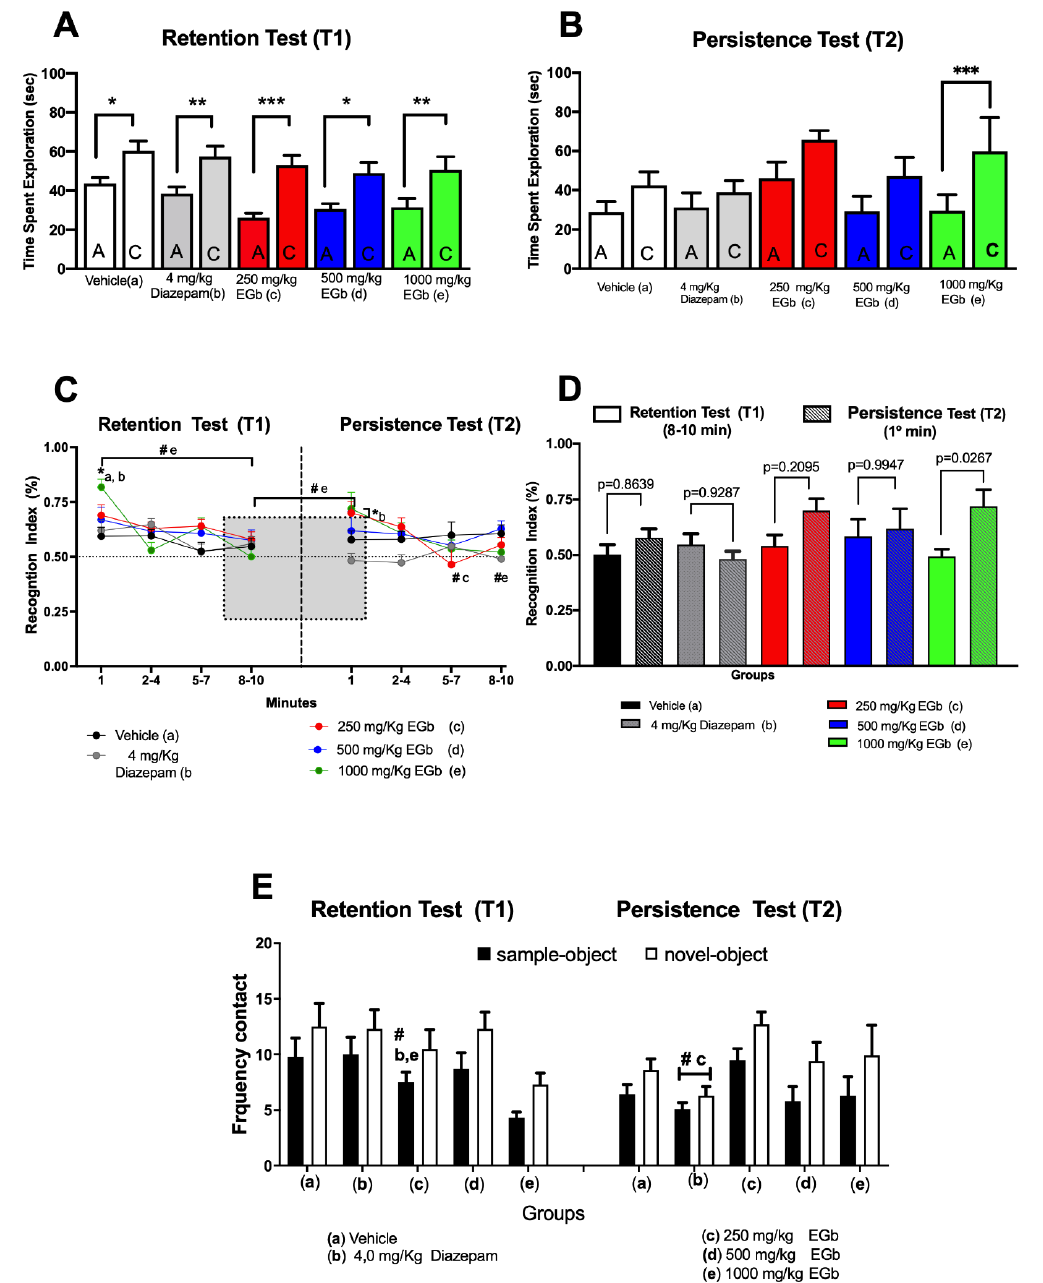
Figure 1. ( A ). Comparison of the mean of total time spent exploring/min the novel and sample objects in the retention test (day 8, n = 20/group), and the persistence test ( B ) (day 9, n = 10/group) between the control (diazepam- and vehicle-treated) and EGb-treated (250, 500 and 1000 mg/kg) groups. ( C ). The recognition index (RI) during the retention and the persistence sessions. The first points indicate the mean RI values during first min of the control (4 mg/kg diazepam- and vehicle-treated) and EGb-treated (250 mg/kg, 500 mg/kg and 1000 mg/kg) groups before the acquisition of ORM (n = 20/group) and the persistence test session (n = 10/group). The subsequent data points represent the mean DI values of nine min in blocks of 3 min (trials) each (2 – 4,5 – 7,8 – 10). EGb, diazepam and vehicle were administered orally 30 min prior to training session. No drugs were administered before retention test (T1) and persistence test (T2) sessions ( D ). Persistence of long-term memory (LTM) was inferred based on a comparison of the time spent spontaneously exploring sample object and that spent spontaneously exploring the novel object during the last three trial blocks at the end of the retention session and during the first trial of the initial persistence session. ( E ). Frequency of contact with the sample and novel objects during the retention test (n = 20/group) and persistence test (n = 10/group) for the groups treated with EGb (250 mg/kg, 500 mg/kg or 1000